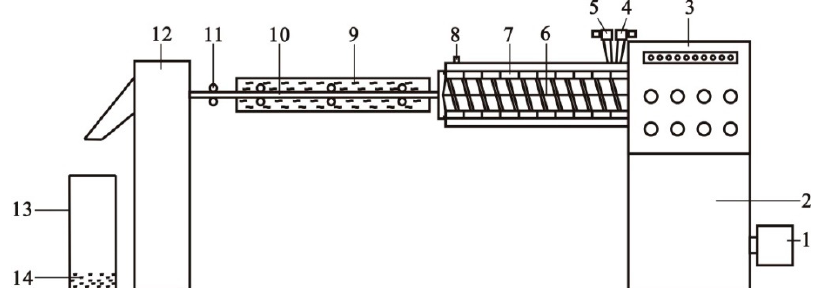
Figure 1. Diagrammatic sketch of the preparing machine for making carbon nanotubes (CNTs)/ Poly(lactic acid) (PLA) master batches. 1— main motor, 2—transmission case, 3— parameter adjustment controller, 4— main feed throat, 5— side feed throat, 6—twin screws, 7— ten heating zones, 8—vacuum